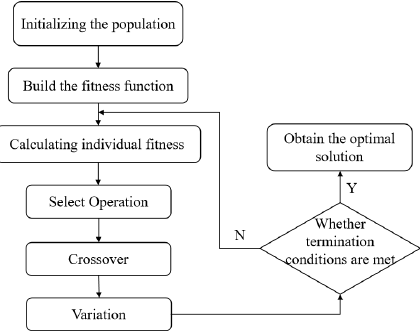
Figure 1. Genetic algorithm flow chart.